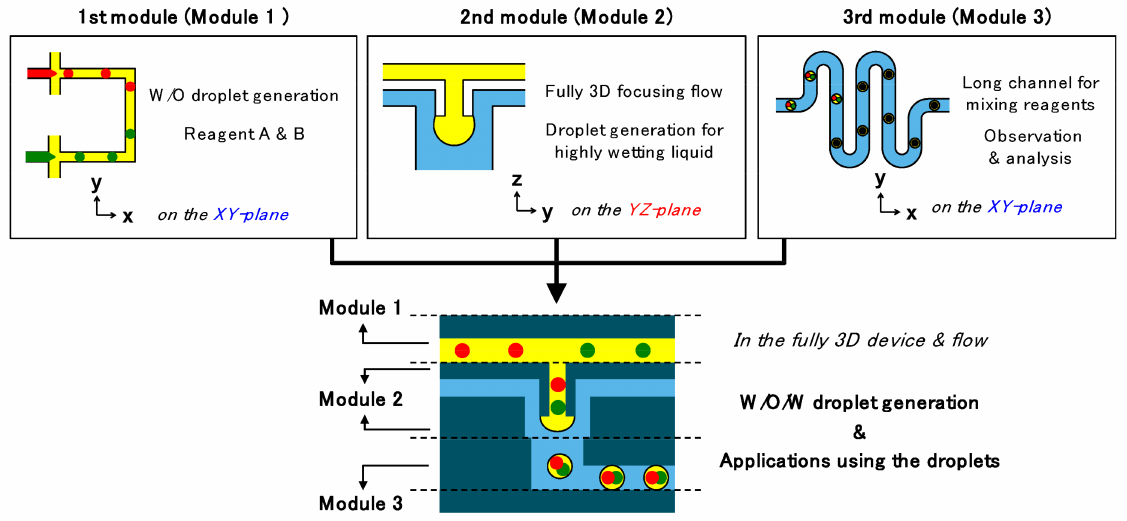
Figure 25. Schematic representation of the device formed by module integration; function and working plane of each module and fully integrated device developed by Yoon et al. Reprinted from an open-access source [85].